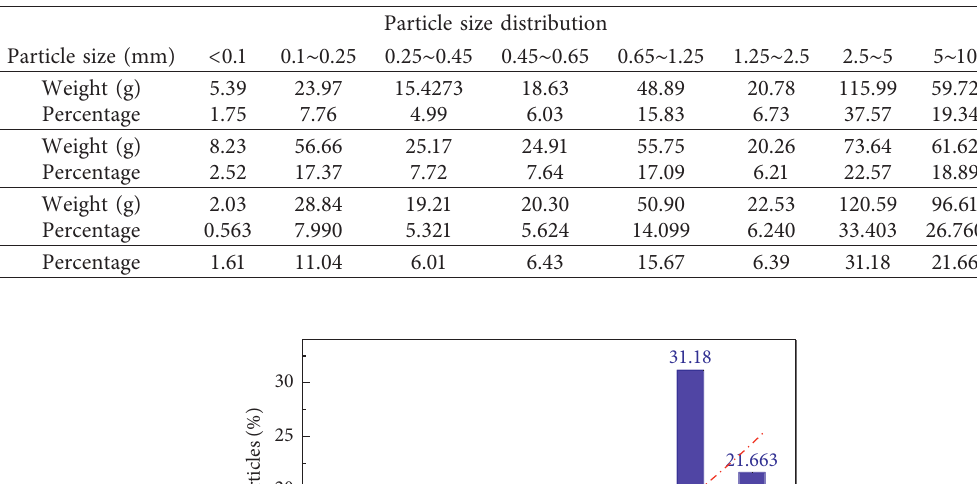
Table 1: Particle size distribution of raw coal.